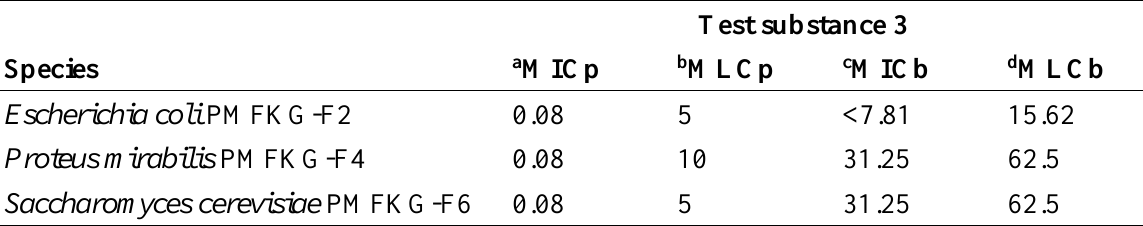
The values in the table are given in µl/ml. a MICp-minimum inhibitory concentration of planktonic cells, b MLCp- minimum lethal concentration of planktonic cells, c MICb- minimum inhibitory concentration of a biofilm, d MLCb- minimum lethal concentration of a